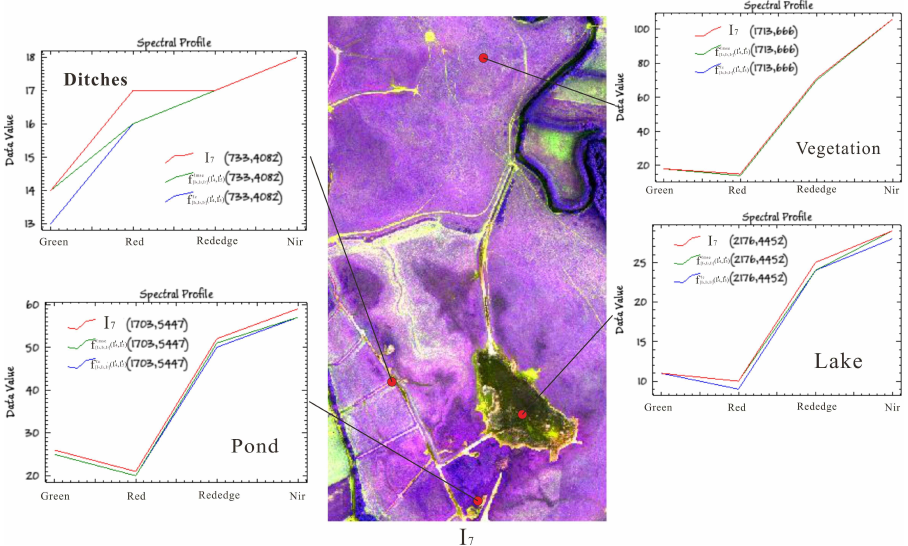
Figure 12. Spectral curves between scene interpolated result and reference scene image using different loss functions at different coordinates in July 2019.